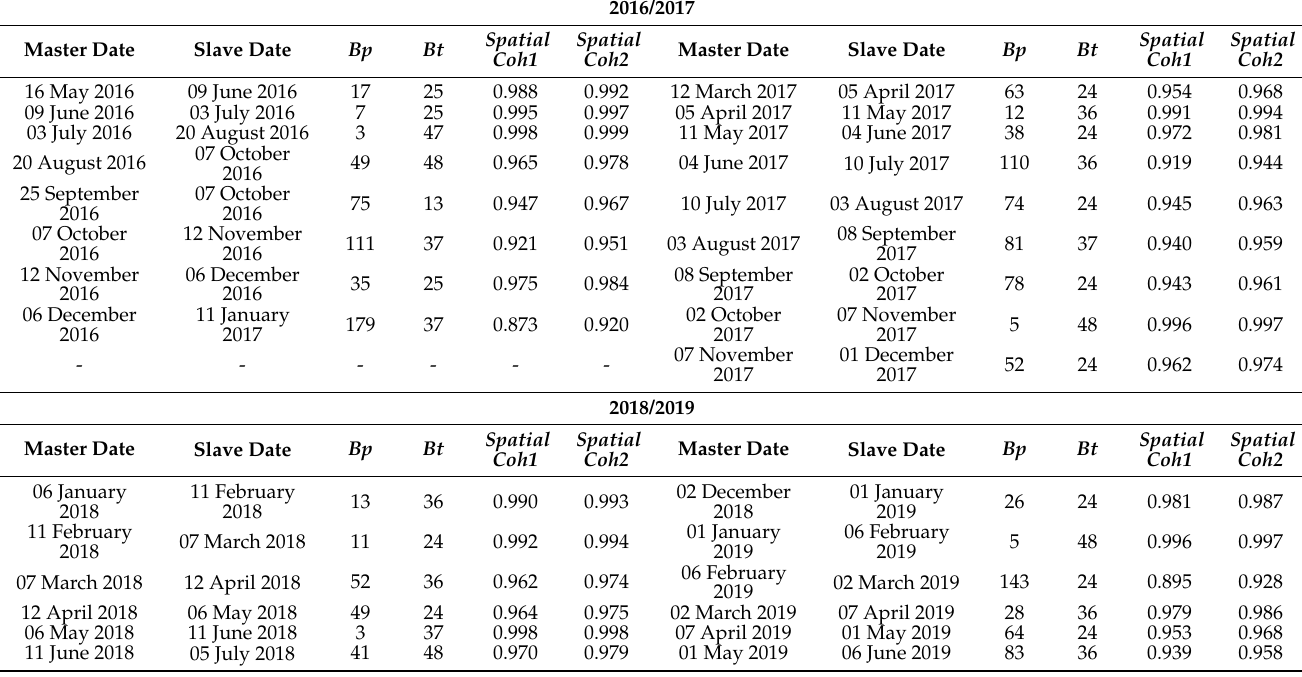
Table 2. Employed Sentinel-1 pairs and their acquisition conditions together with spatial phase coherences ( Bp : perpendicu- lar baseline (m), Bt : temporal baseline (day), Spatial coh1 : spatial phase coherences in mean topographic slope angle (3.34 ◦ ), Spatial coh2 : spatial phase coherences in mean topographic slope angle (28.3 ◦